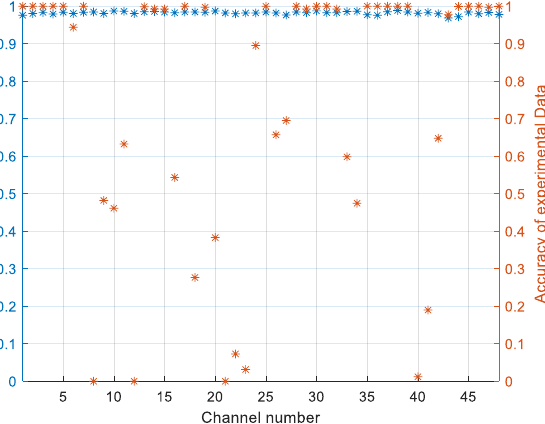
Figure 15. The kNN validation results (precision, recall and F1) of simulation data of all 48 hydrophones.